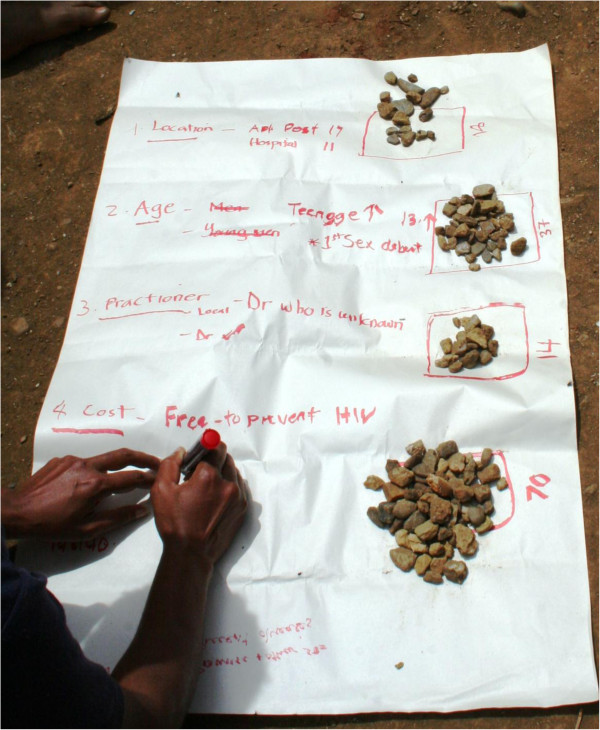
Example of an activity completed during participatory workshops.